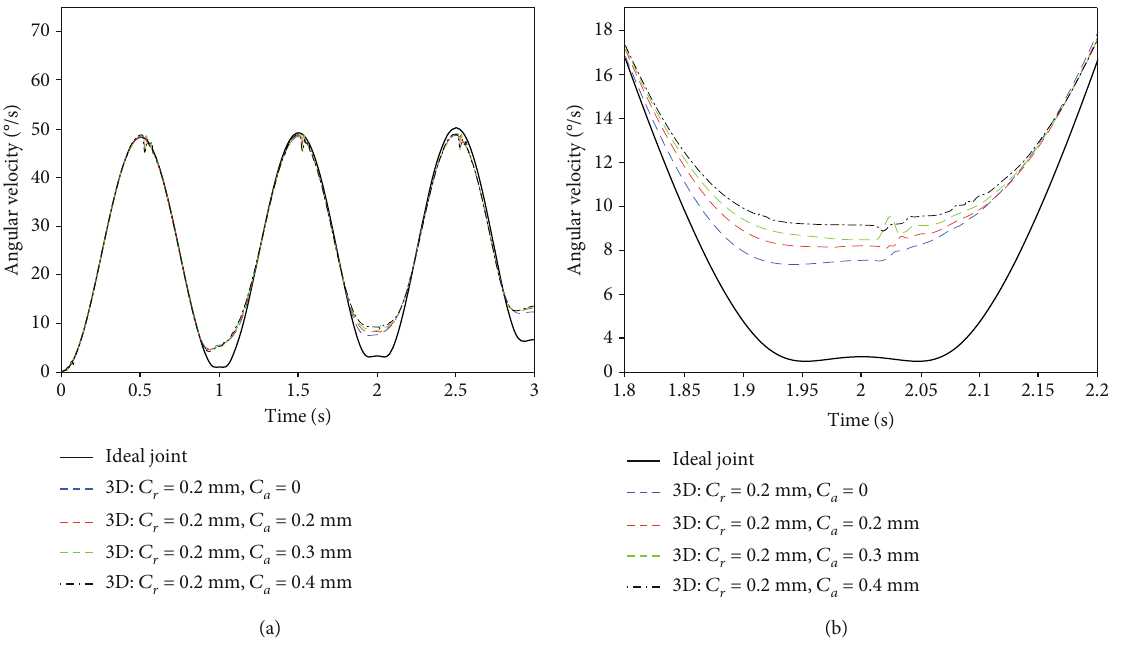
Figure 12: Angular velocity of the antenna: (a) angular velocity; (b) partial